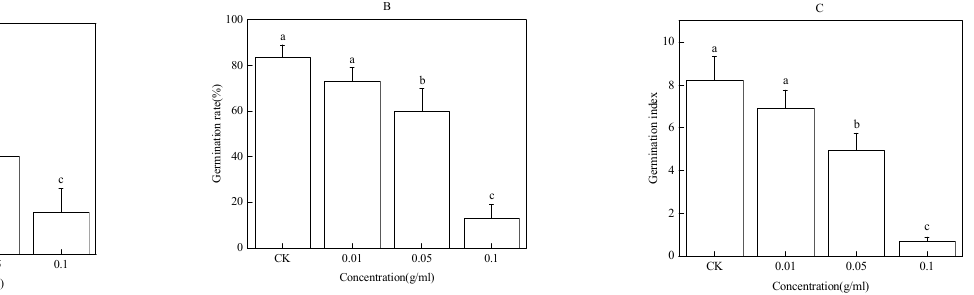
Figure 1. Effect of water extract of faba bean roots on germination energy (GE) ( A ), germination rate (GR) ( B ), and germination index (GI) ( C ) of faba bean seeds. Data are presented as the mean ± standard error of three biological replicates. Various letters for each index indicate significant differences at p < 0.05.